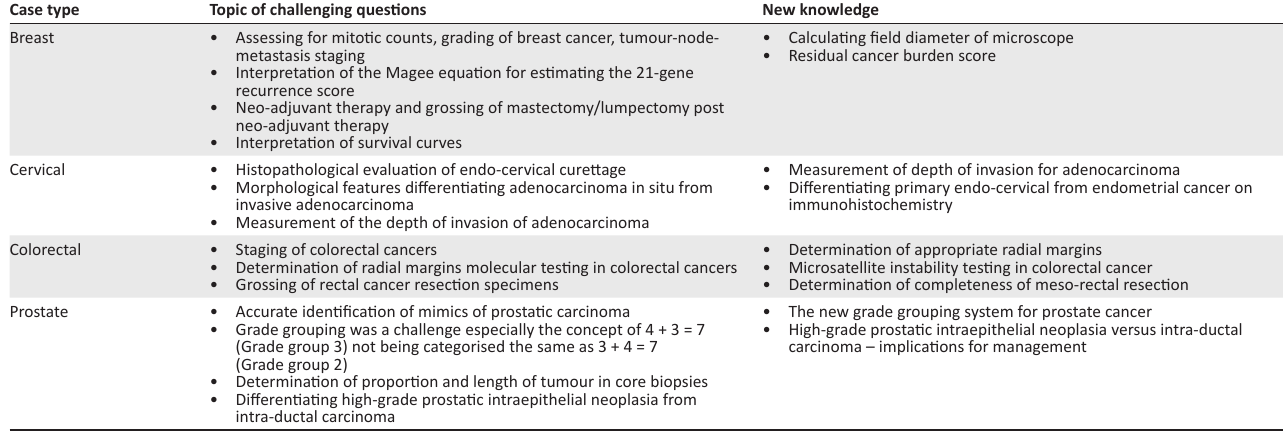
TABLE 1: Case type, challenges encountered and new knowledge